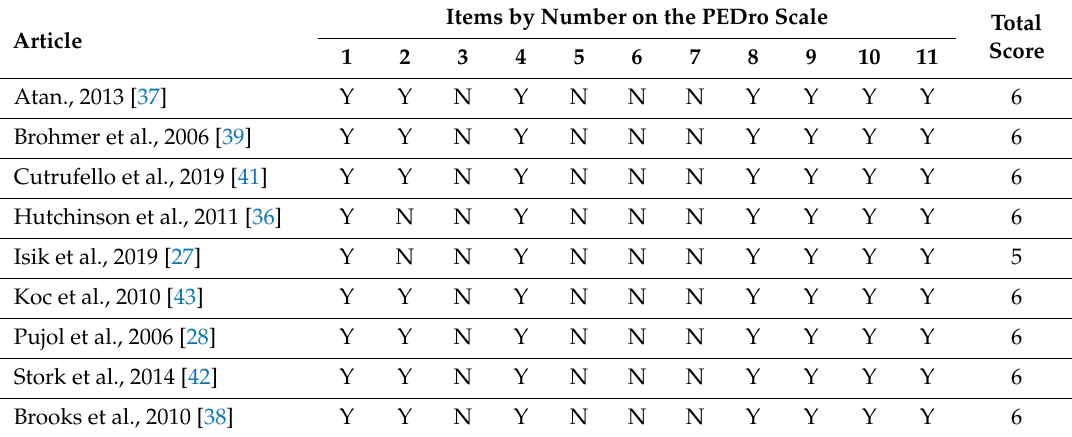
Table 2. Quality assessment with the PEDro